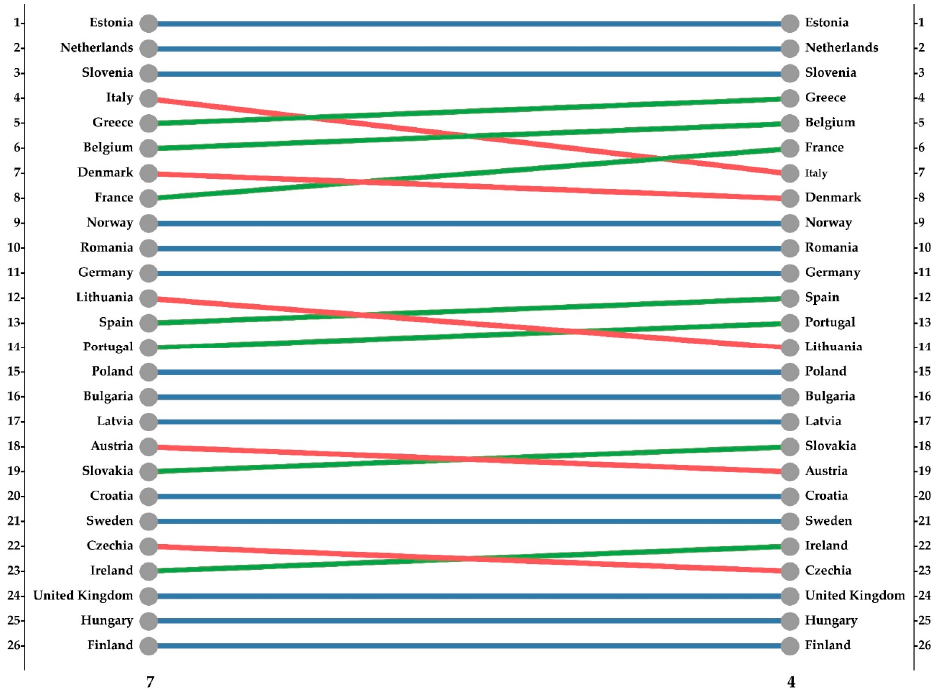
Figure 6. Differences in ranking between Window Width equals to 7 (left) and 4 (right).